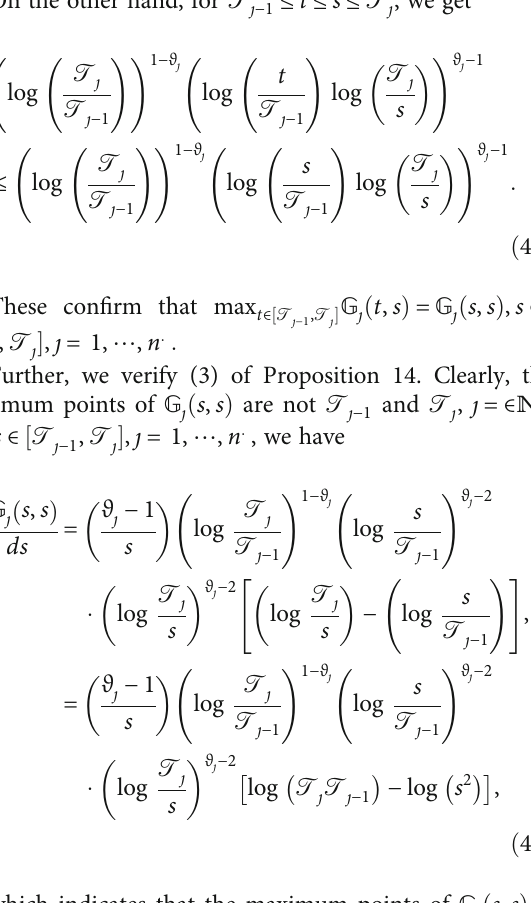
ffiffiffiffiffiffiffiffiffiffiffiffiffiffiffi T